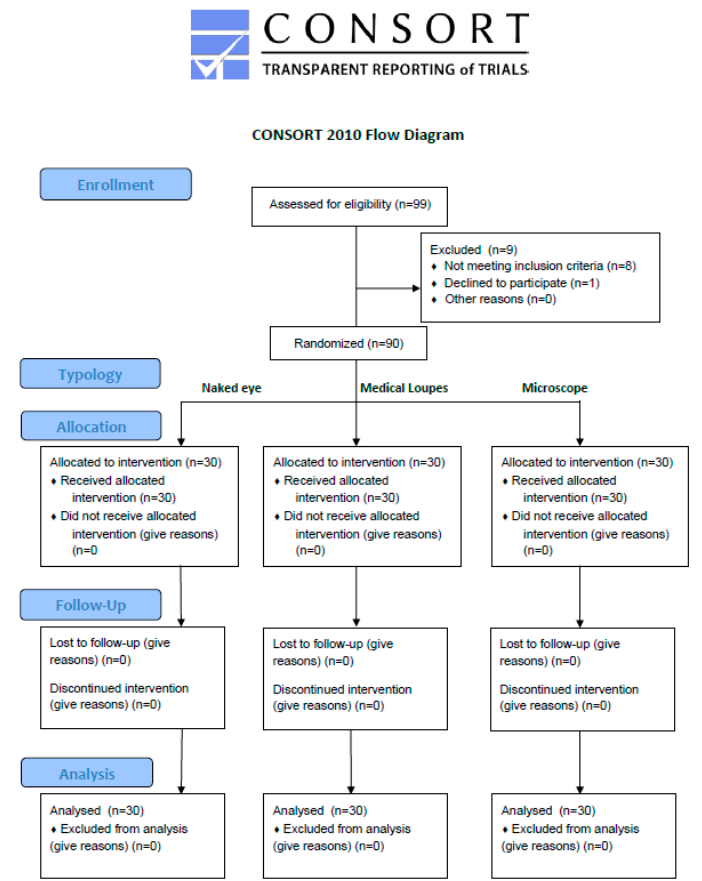
Figure 10. Consort 2010 Flow Diagram realized according to the CONSORT statement recommendations for randomized trials [31].